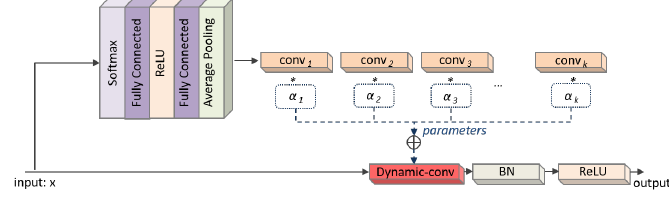
Figure 2. Illustration of dynamic convolution